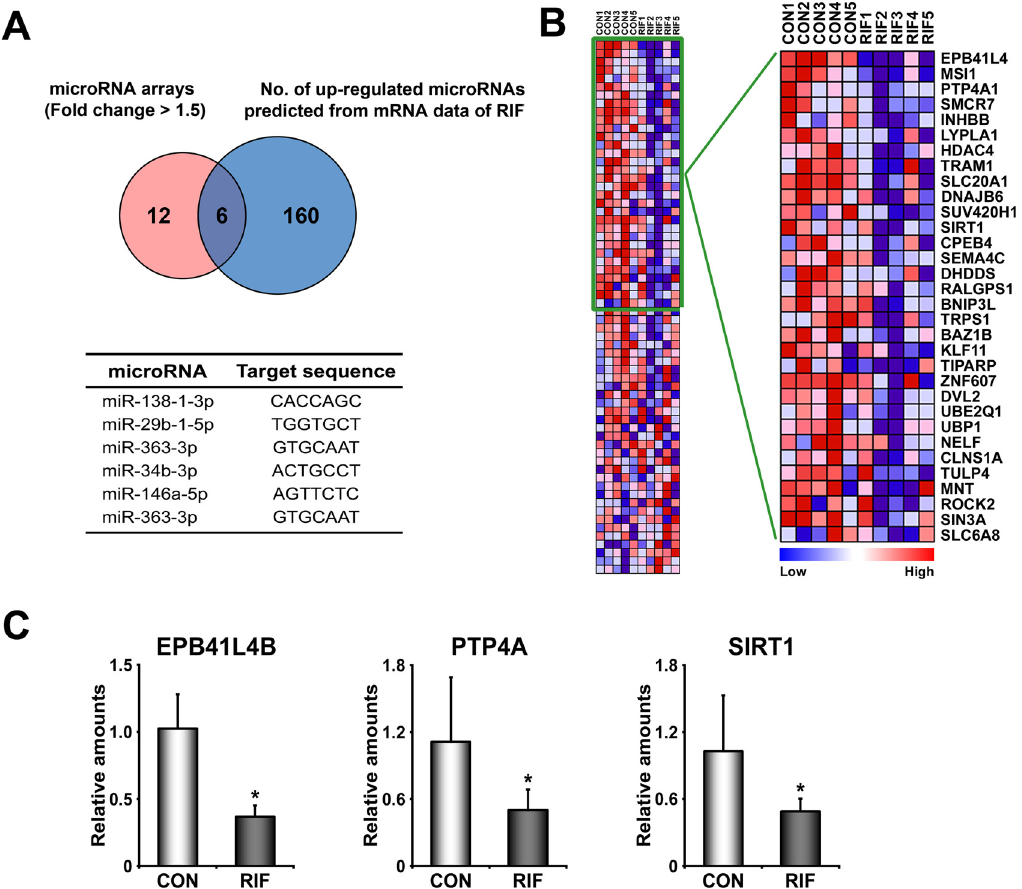
Fig 5. Dysregulated microRNAs in the endometrium of patients with RIF. A) A Venn diagram to show the number of up-regulated microRNAs collected from microRNA arrays and mRNA arrays in the endometrium of patients with RIF. MicroRNA arrays provided a list of 18 differentially expressed microRNAs, and GSEA with total expression profiles of mRNAs predicted 166 putative microRNAs. Six microRNAs (as listed in a table at the bottom) are overlapped between these two microRNA lists. B) A heatmap of putative target genes of miR-138-1-3p analyzed by GSEA. Genes within the green box are leading characters for building enrichment scores in CON. The color spectrum from blue to red indicates low to high expression. C) The results of realtime RT-PCR to validate down-regulation of putative target genes of miR-138-1-3p which is one of significantly up-regulated microRNAs in RIF. CON and RIF represent endometrium of healthy fertile women and patients with RIF, respectively. * , p <